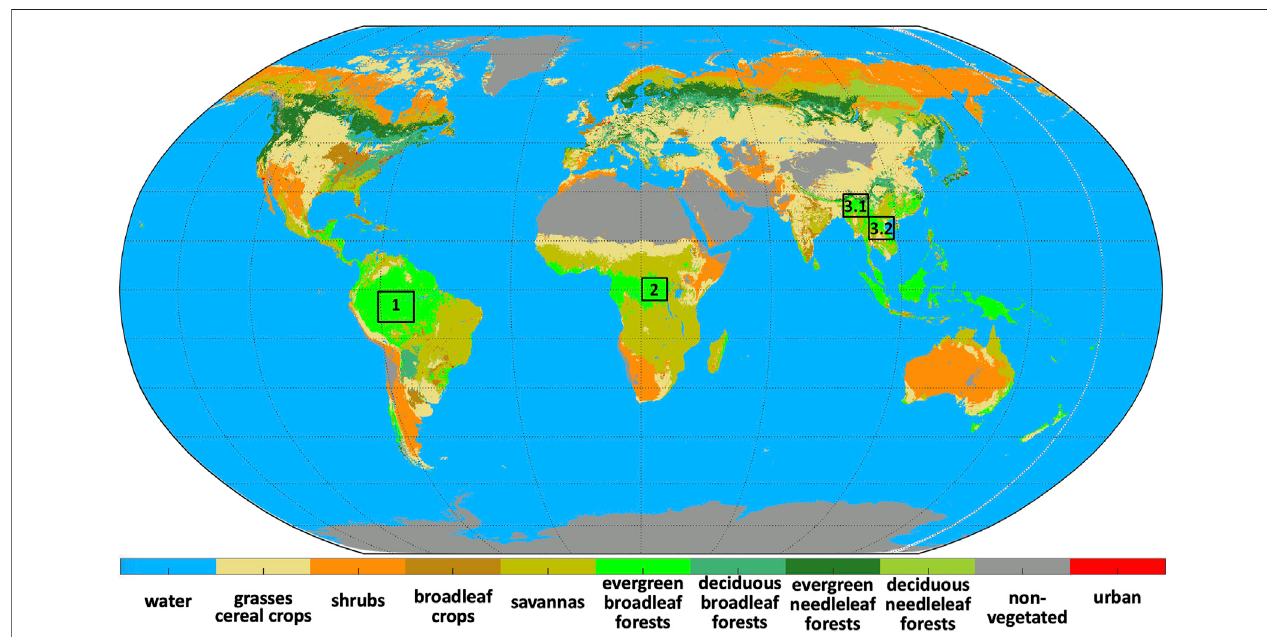
FIGURE1| DSCOVREPIC10 kmlandcovermap(WWW-VESDR2021)onRobinsonprojectionwithCentermeridianat20 ° E.OurstudyareaincludesAmazonian central rainforest (Region 1: 0 ° – 10 ° S and 70 ° – 60 ° W), Congo rainforests (Region 2: 5 ° S – 5 ° N and 20 ° – 30 ° E) and Southeast Asian rainforest (Region 3.1: 23.50 ° – 26.57 ° N and 92.5 ° – 98.62 ° E; Region 3.2: 19.80 ° – 21.54 ° N and 97.93 ° – 105 ° E). Our study areas are depicted as squares, which are part of evergreen broadleaf forests.